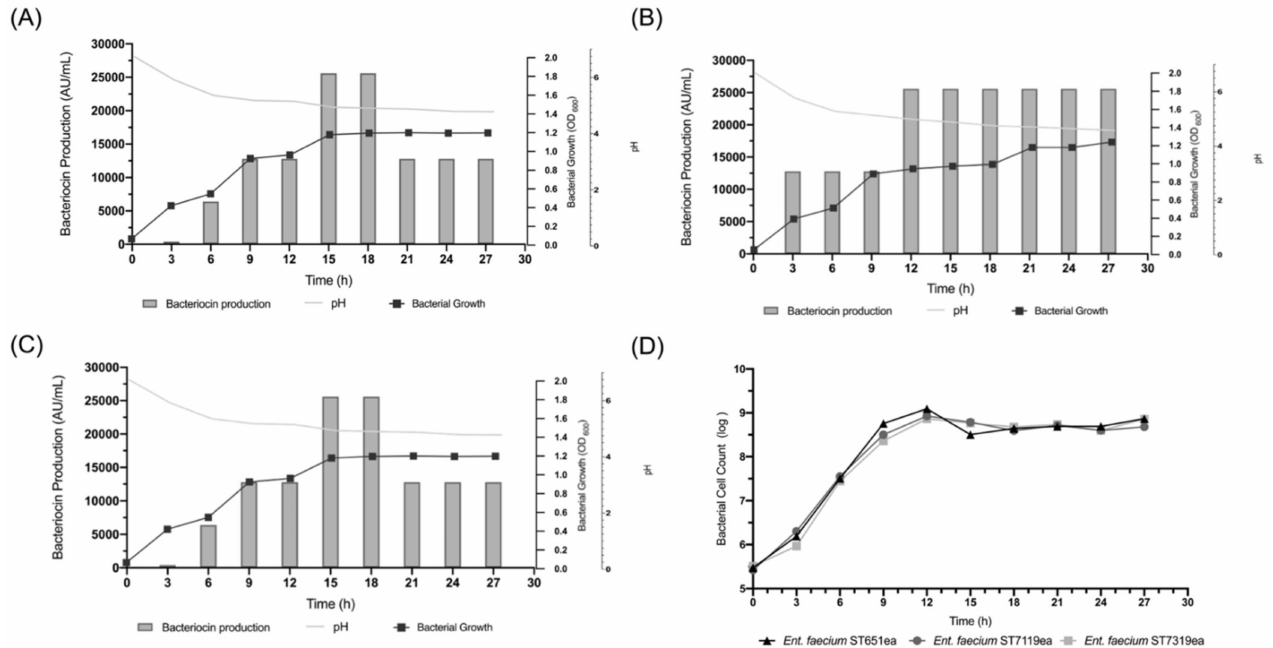
Figure 1. Bacterial growth, bacteriocin production and acidification of strains ( A ) E. faecium ST651ea, ( B ) E. faecium ST7119ea, ( C ) E. faecium ST7319ea and ( D ) corresponding bacterial cell